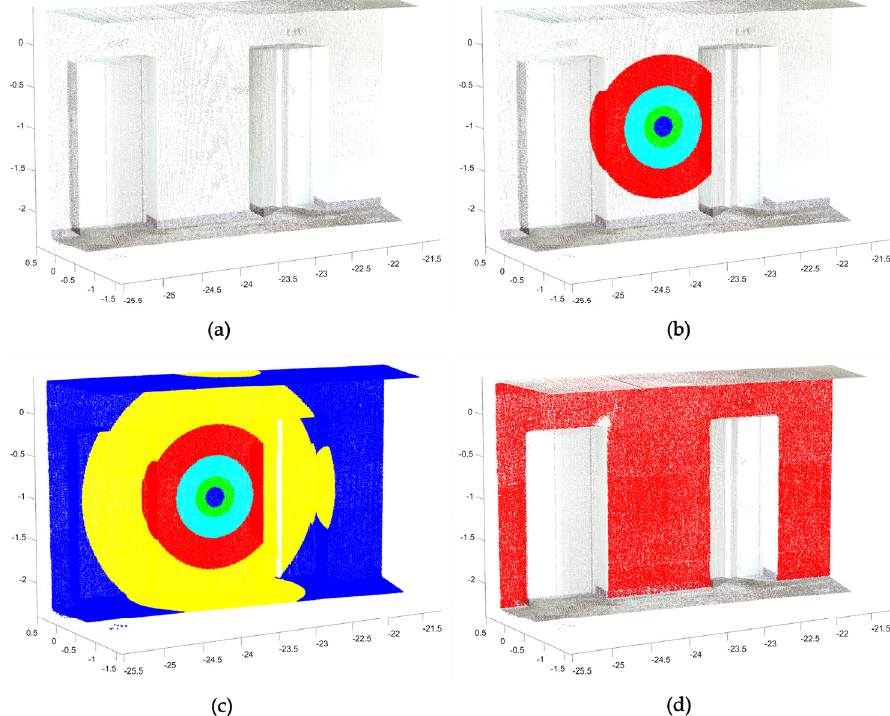
Figure 3. Segmentation of planes: ( a ) the initial point cloud; ( b ) the 1600 nearest points to the selected seed point with dark blue, 6400 nearest points with green, 25,600 nearest points with light blue, and 102,400 nearest points with red; ( c ) the 409,600 nearest points with yellow and 1,638,400 nearest points with blue; ( d ) the plane segmentation result (the inlier points) with